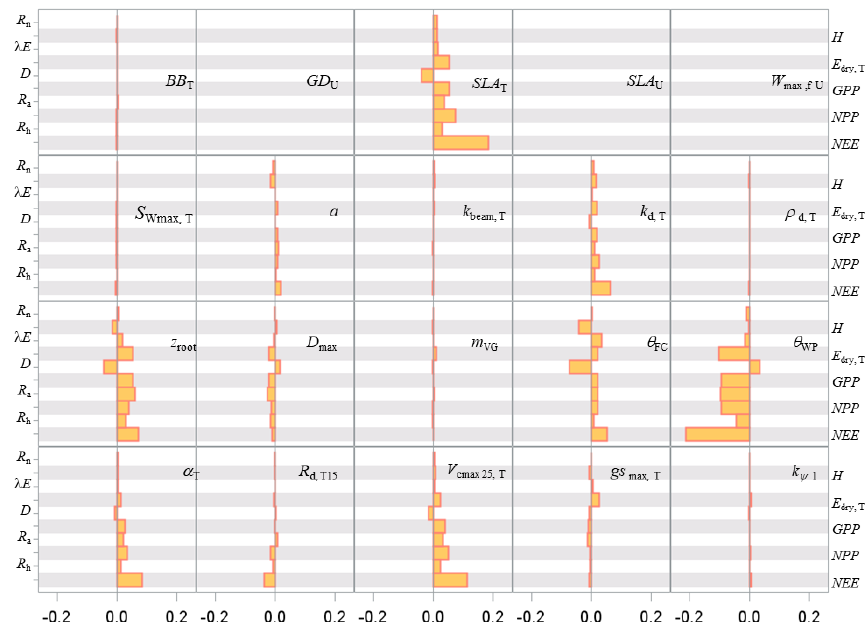
Figure 8. Sensitivity index values of the main variables related to the energy, water and carbon fluxes to model parameters over a full rotation (1970–2010) at the Le Bray site. The abbreviations of the variables (vertical axes) are explained in Table A1 and parameter abbreviations (inset) are detailed in Table S1.